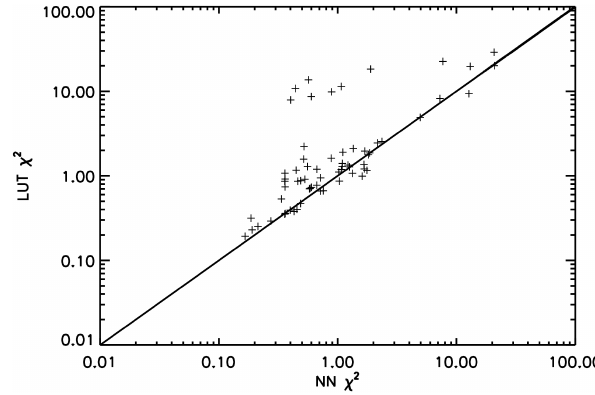
Figure 4. Plot of the final χ 2 obtained using the LUT + PT scheme (ordinate) versus that obtained using the NN + PT scheme (ab- scissa) for the considered groundSPEX